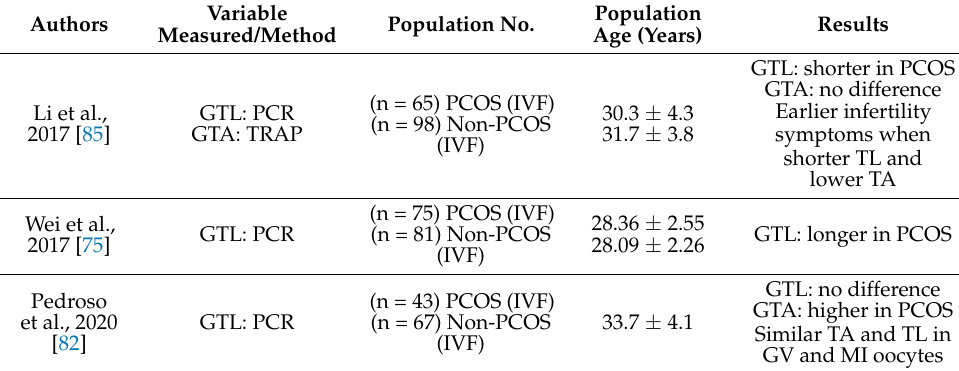
Table 2. Studies measuring telomere length/telomerase activity in granulosa cells in PCOS.